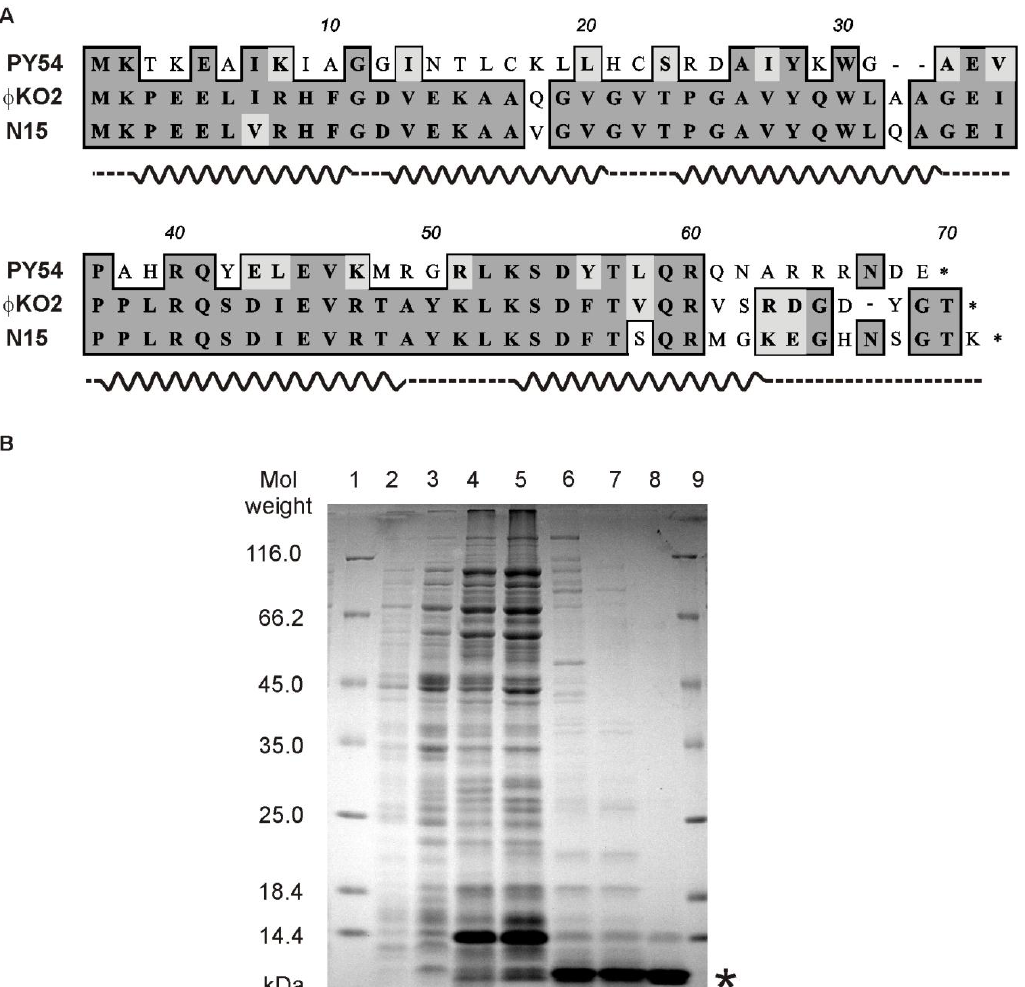
Figure 3. Sequence analysis and purification of PY54 Cro. ( A ) Alignment of the amino acid sequences of the Cro repressors of PY54, φ KO2 and N15. Similar and identical residues at corresponding positions are shown in light grey and dark grey, respectively. Helices deduced from the structural data on N15 Cro of Dubrava et al. [11] are indicated; ( B ) Purification of the PY54 Cro repressor. SDS-PAGE (12.5%) of the crude extract and pooled peak fractions of the three steps of PY54 Cro purification. Lanes 1 and 9, molecular weight marker; lanes 2 and 3, crude extract of the noninduced and IPTG-induced E. coli strain SCS1 (pJH142-2) containing the cro gene of PY54 (Tables S1 and S2); lane 4, Brij-58/lysozyme extract of induced cells; lane 5, extract after ammonium sulfate precipitation; lane 6, Heparine-Sepharose; lane 7, DEAE-Sephacel; lane 8, CM-Sepharose. The overproduced Cro protein is indicated by an asterisk. Further information on the purification of Cro is given in the Supplemental Material.